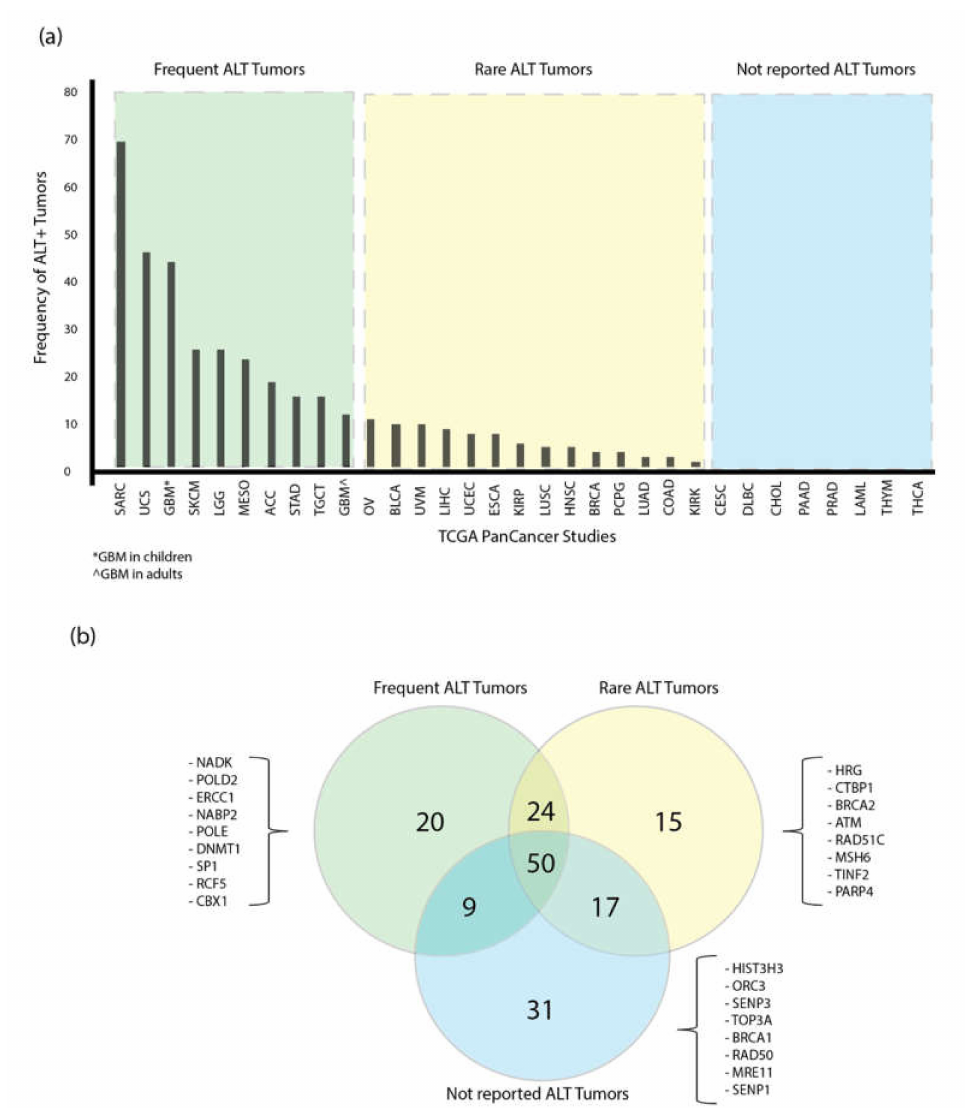
Figure 4. ALT mechanism prevalence in the PCA studies and its relationship with TM altered genes. ( a ) Shows the prevalence of the ALT mechanism in the 31 PCA studies; tumors were classified in three groups depending on the values above the mean as: Frequent ALT tumors, rare ALT tumors and not reported. ( b ) A Venn diagram showing the distribution of the most altered ALT-related genes in each ALT tumor